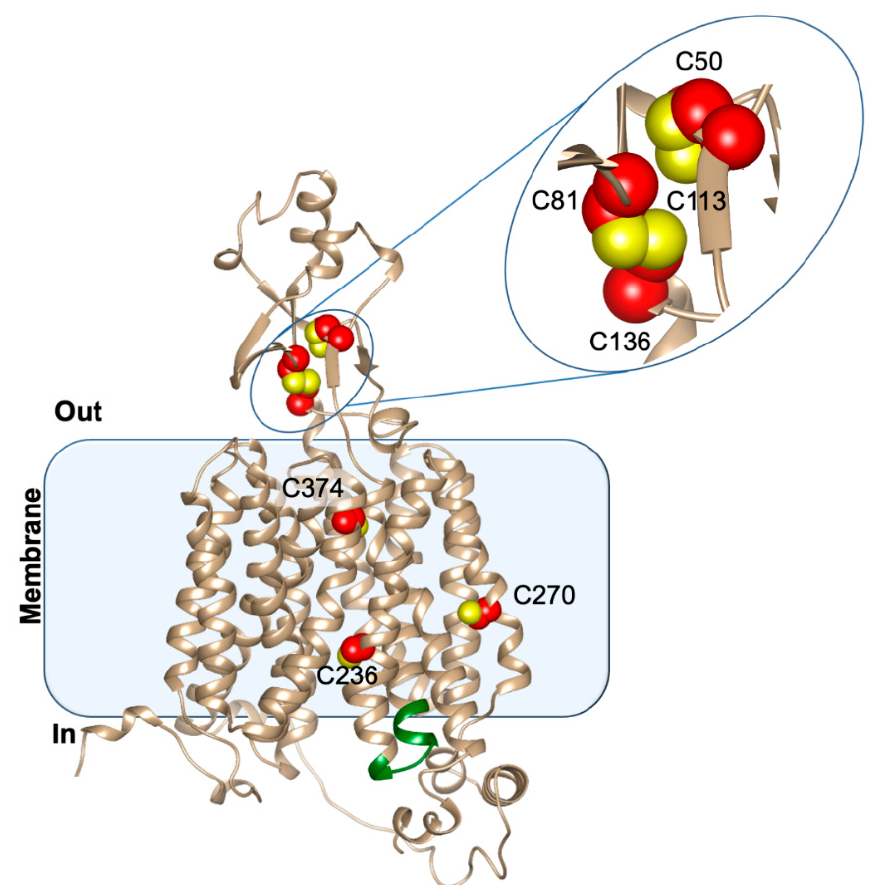
Figure 2. Ribbon representation of the OCTN1 structural model retrieved from Alphafold database. Cysteine residues are depicted as red spheres with Sulphur atoms in yellow. The intracellular nucleotide binding site is colored in green.